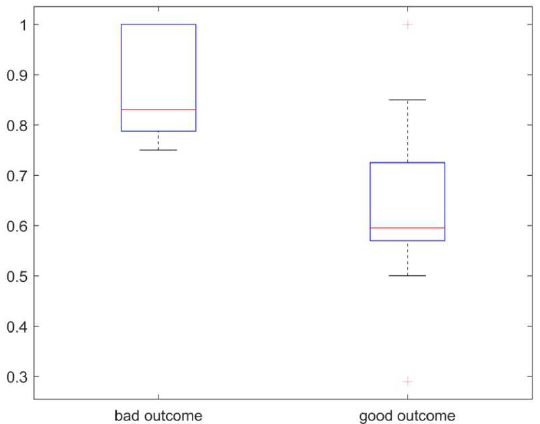
Figure 3. Boxplot of recanalization quotient (0 = complete recanalization, 1 = no recanalization) in procedures with bad outcome (worsening of mRS) and good outcome (improvement of mRS). Table 3 summarizes intervals from symptom onset to MT, MT details, outcomes and complications. Table 3. Procedural information and